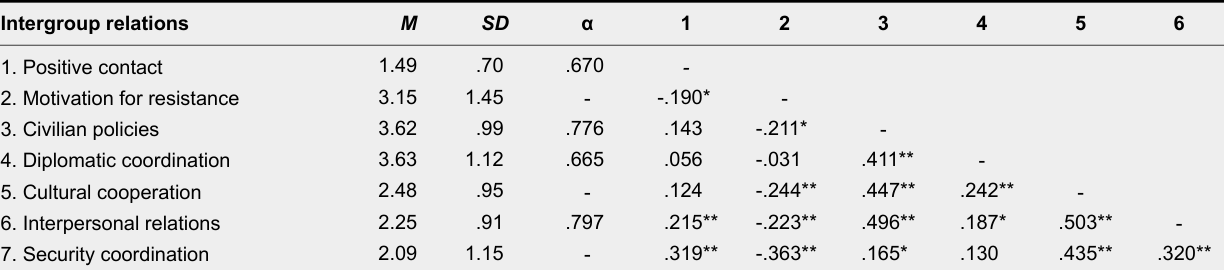
Means (Standard Deviations, Reliabilities, and Correlations Between Intergroup Contact, Support for Normalization and Resistance)